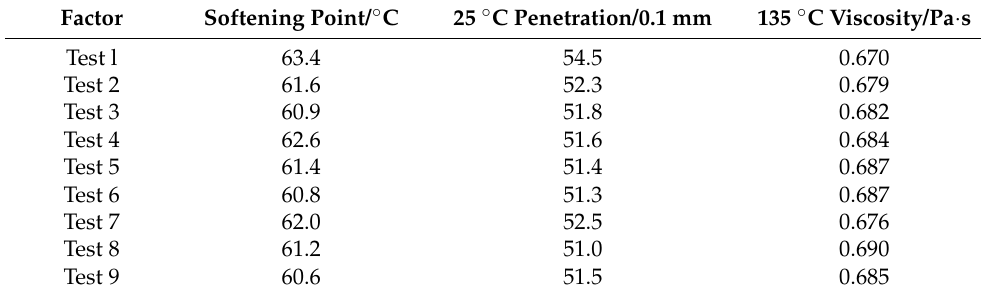
Table 9. Properties of PP-modified